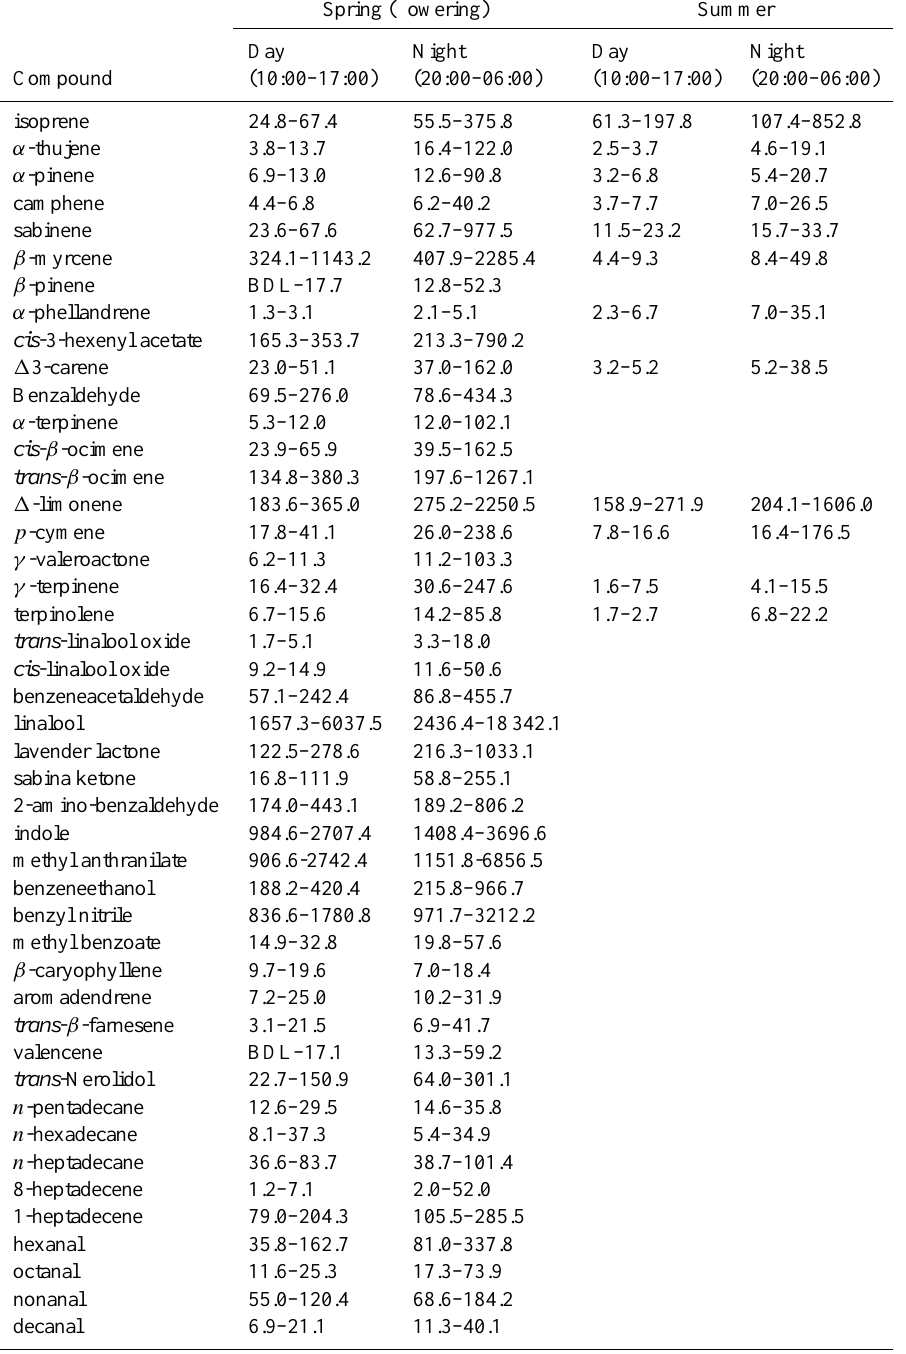
Table 3. Interquartile ranges [pptv] for measured biogenic compounds in spring and